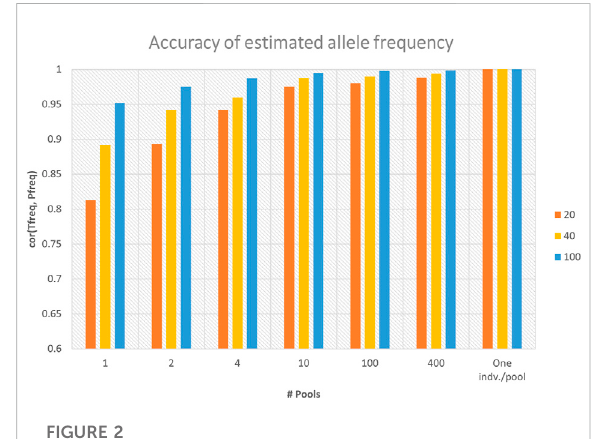
FIGURE 2 Accuracyofmarkerallelefrequencycalculatedfromdifferent numbers of in-silico DNA pools and sequencing depths. Accuracy was calculated as the Pearson correlation coef fi cient between the true allele frequencies ( “ Tfreq ” ) (i.e., calculated from the individual genotypes) and frequencies calculated using in-silico DNA pools ( “ Pfreq ” ) ( n = 1, 2, 4, 10, 100, and 914). There were 914 individuals, and the maximum number of pools ( n = 914) represents one individual per